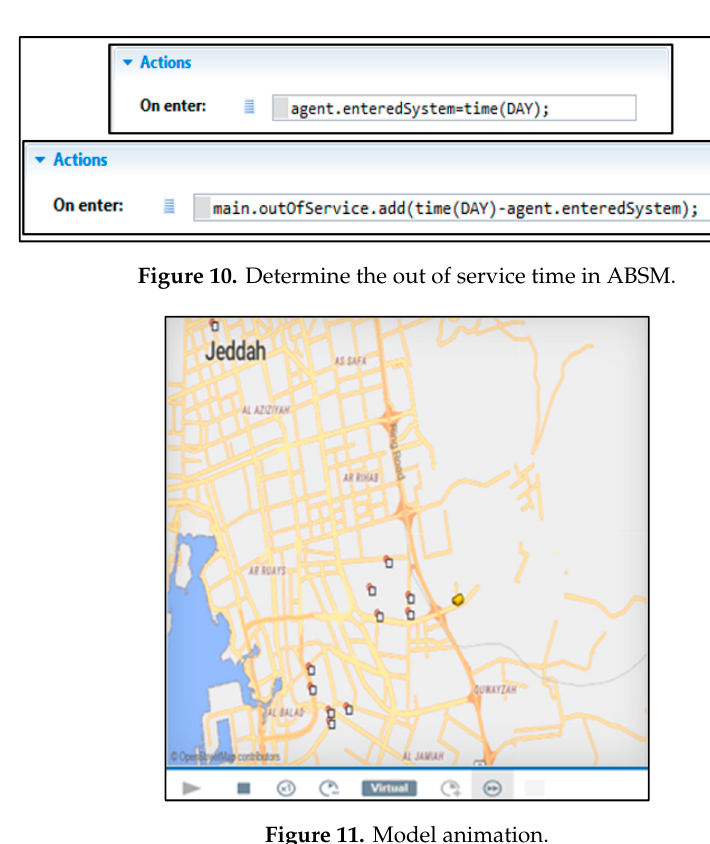
Figure 11. Model